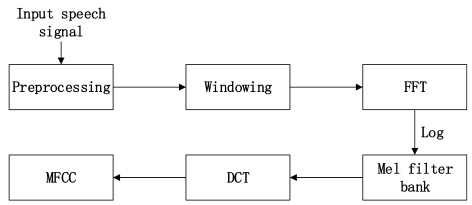
Figure 2. Process of extracting Mel-Frequency Cepstral Coefficient